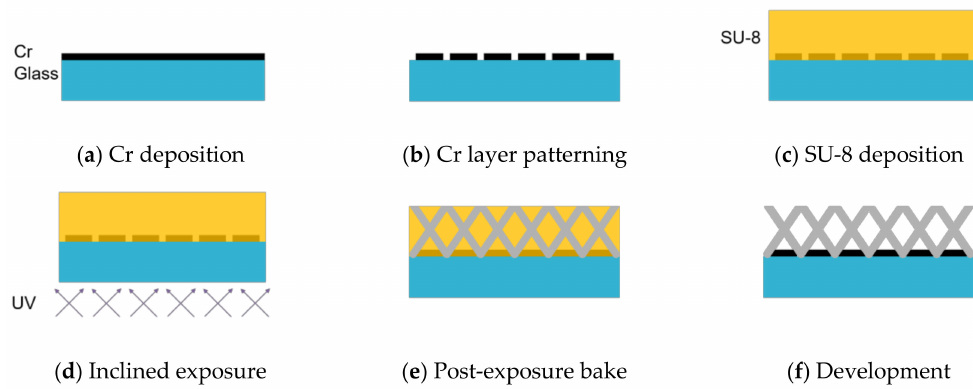
Figure 2. Process flow for vertical porous membrane on Cr patterned glass substrate by inclined exposure. The vertical porous membrane was fabricated by inclined exposure from the back side of the substrate. Because patterns created in advance using Cr patterns were used, a contact gap was not generated between the Cr pattern and SU-8, and no alignment was necessary.